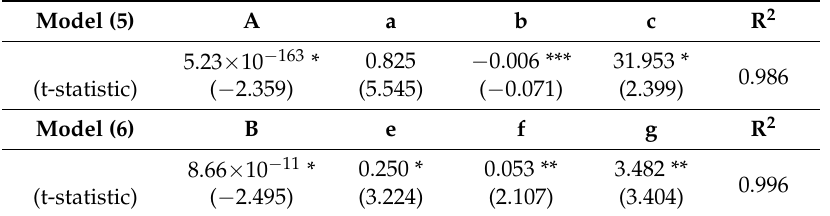
Table 3. Regression results of models (5) and (6) in W